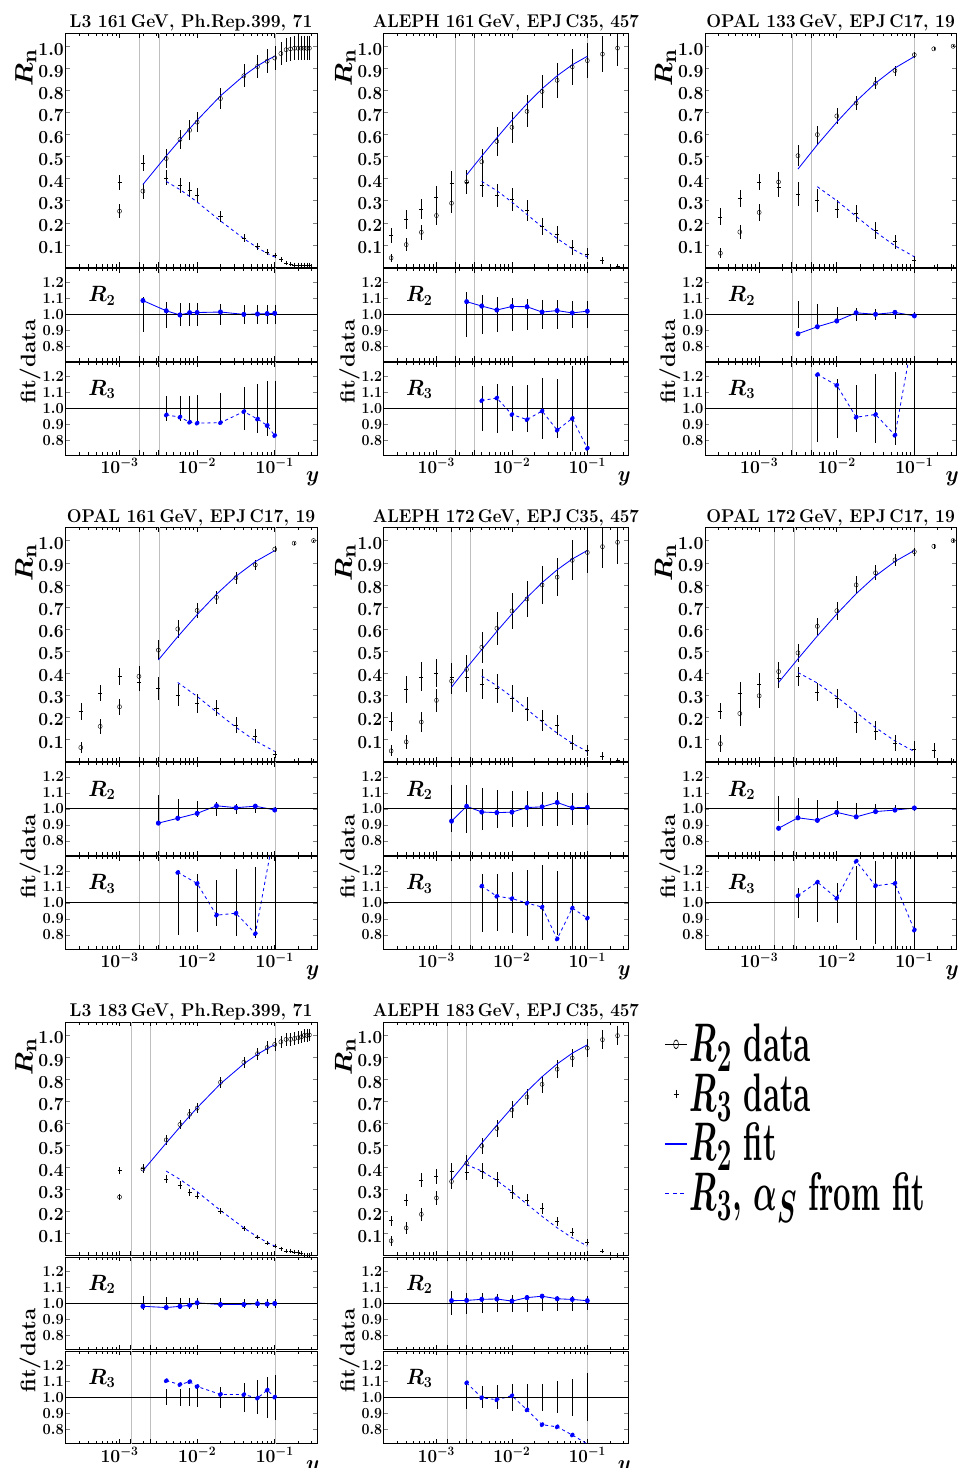
Figure 2 . Comparison of data and perturbative predictions supplemented by hadronization cor- rections in the H L model using for the strong coupling the value obtained from our global (cid:12)t, eq.